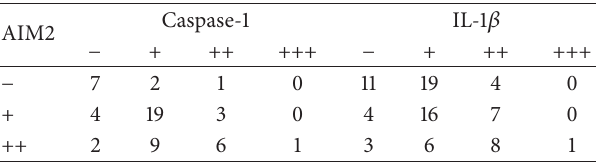
Table 5: Correlation of AIM2, caspase-1, and IL-1 𝛽 expression in